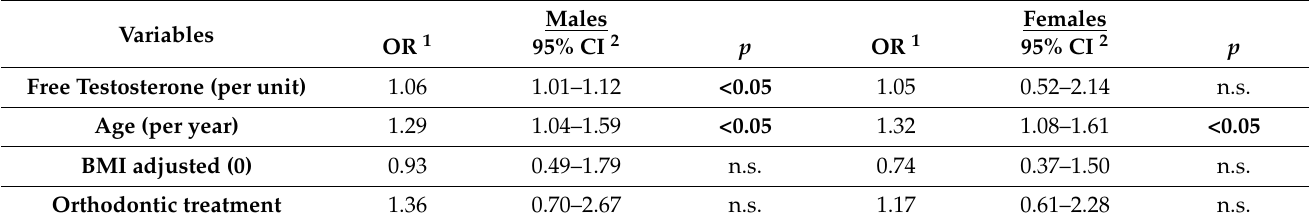
Table 2. Multivariable analyses of risk for tooth wear in male and female